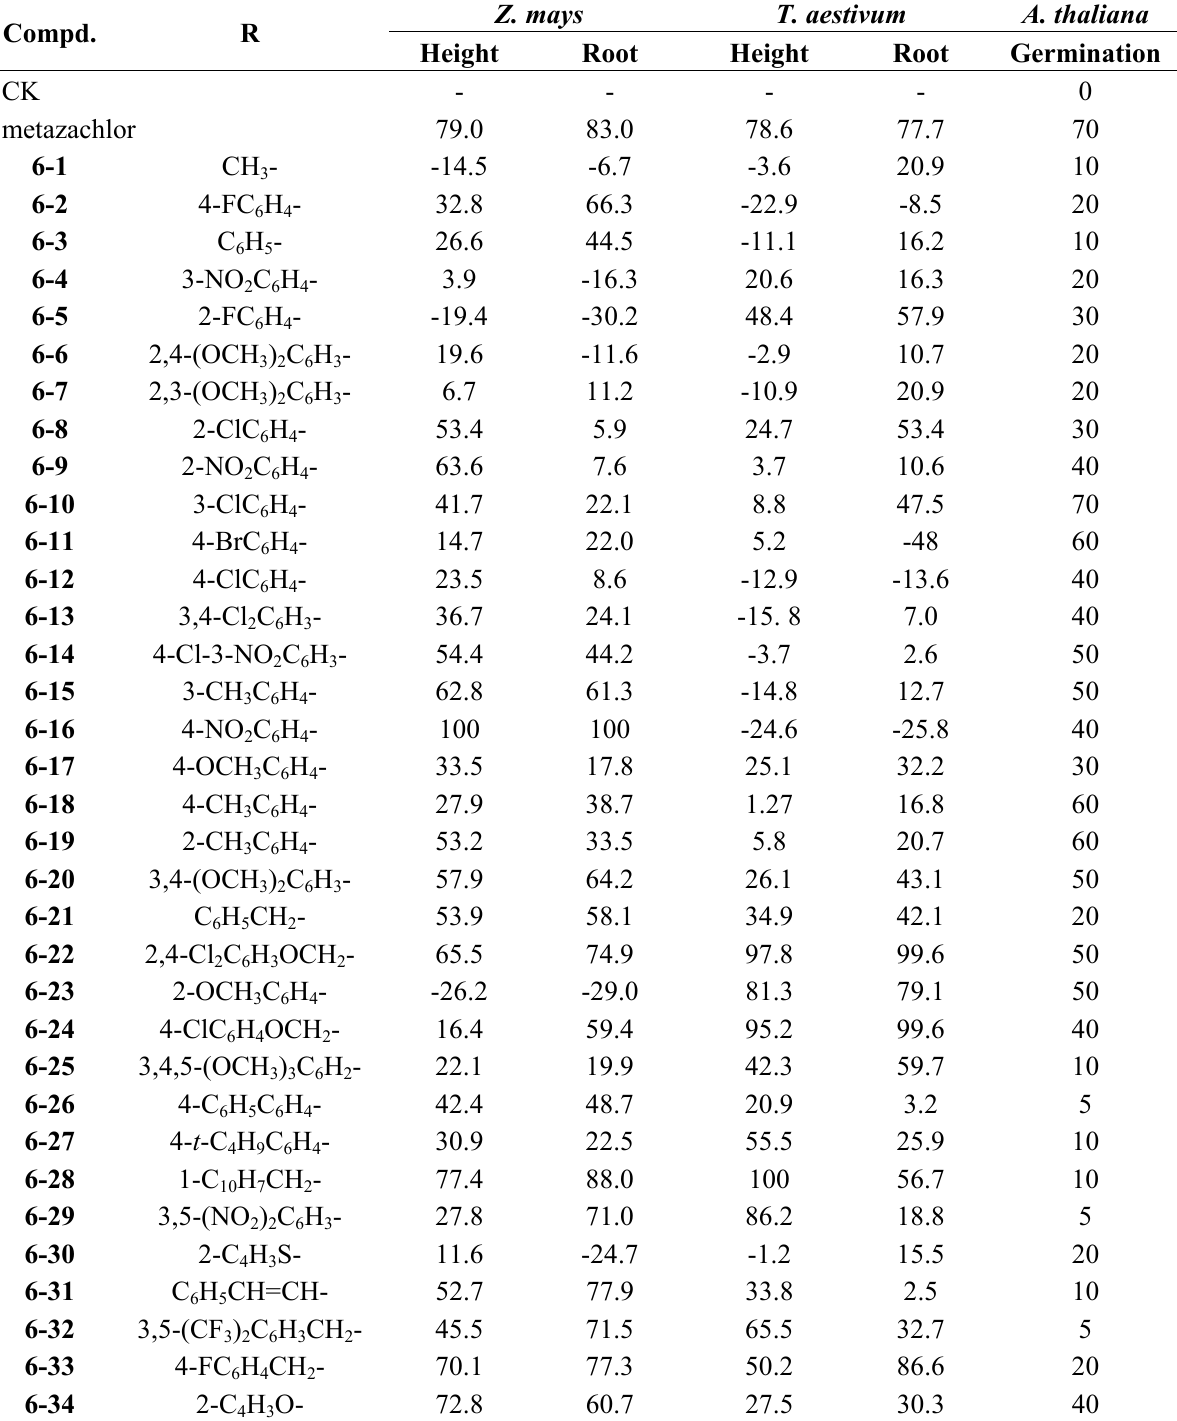
Table 1. The inhibition ratios (%) of 6 against Z. mays , T. aestivum and A. thaliana at 200  g/mL.